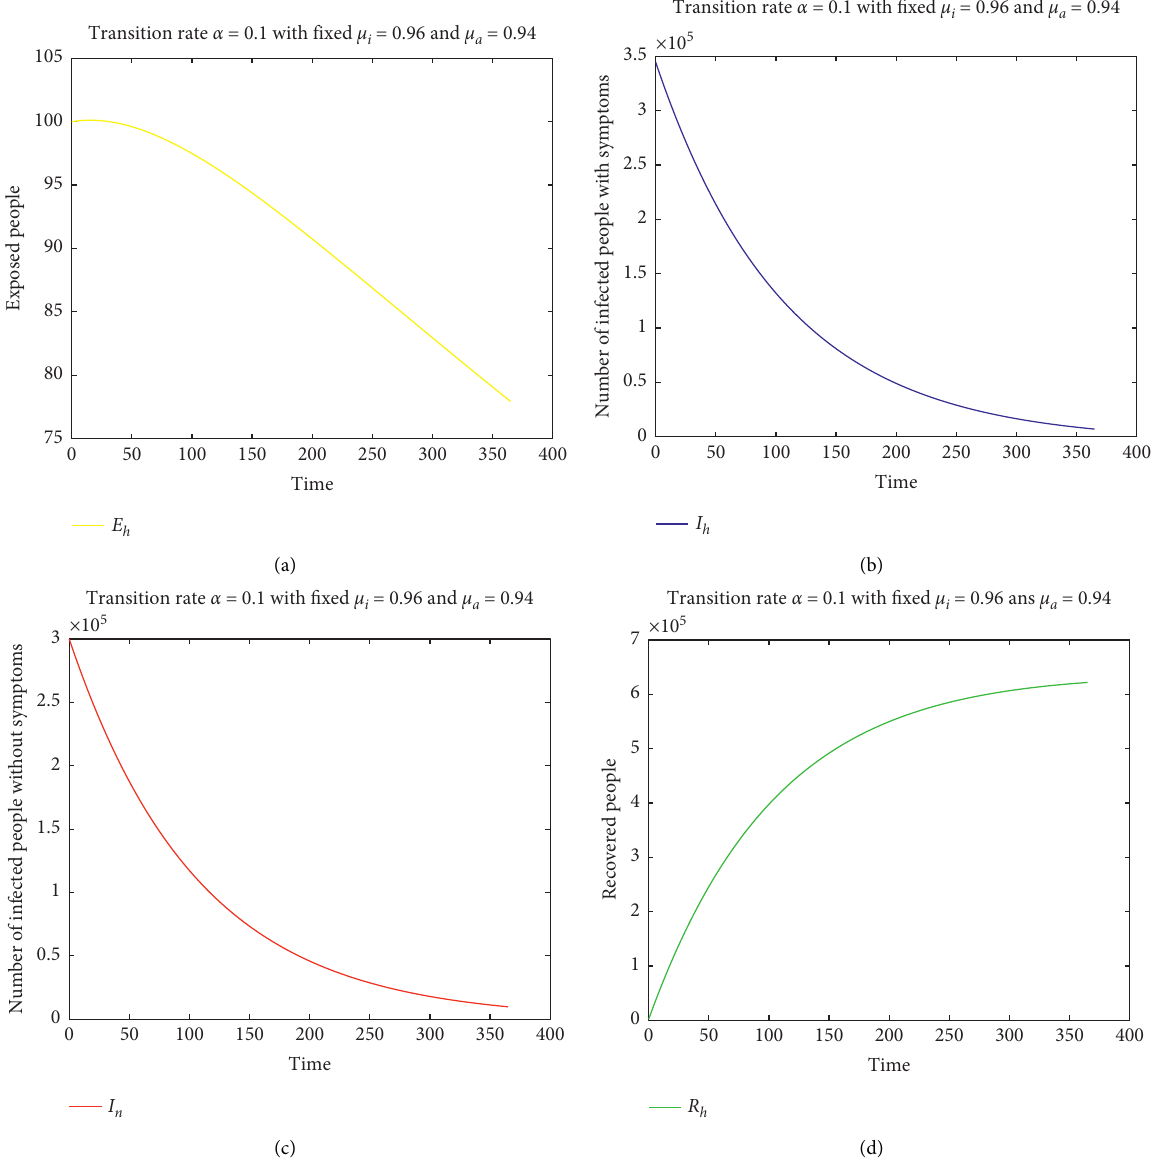
Figure 8: Outbreak dynamics with an infection rate of the virus to the exposed individuals at the infected environment α � 0 . 1: (a) exposed; (b) infected people with symptoms; (c) infected people without symptoms; (d) recovered